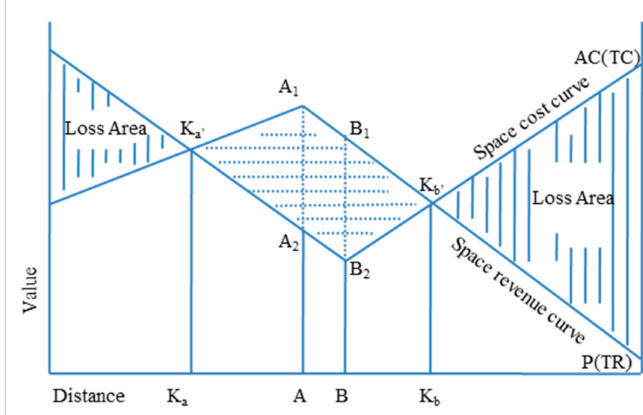
Figure 3. Profitable Spatial Boundary Location model (PSBL).